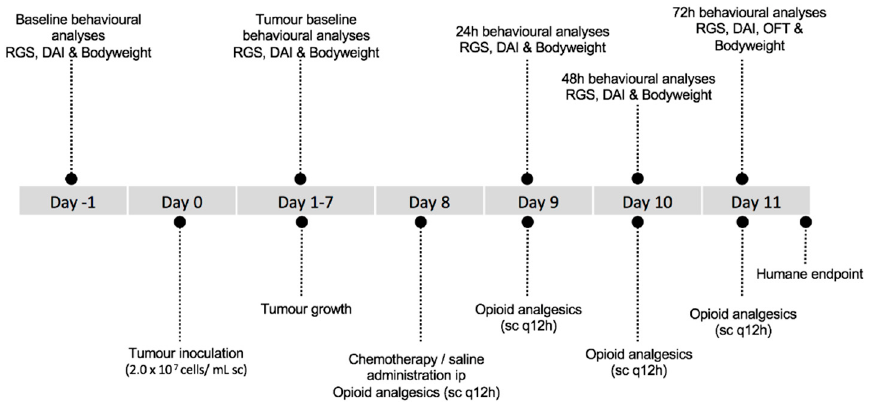
Figure 1. Overview of the experimental timeline for treatment and behavioral analyses. Abbreviations: RGS—rat grimace scale, DAI—disease activity index, OFT—open field